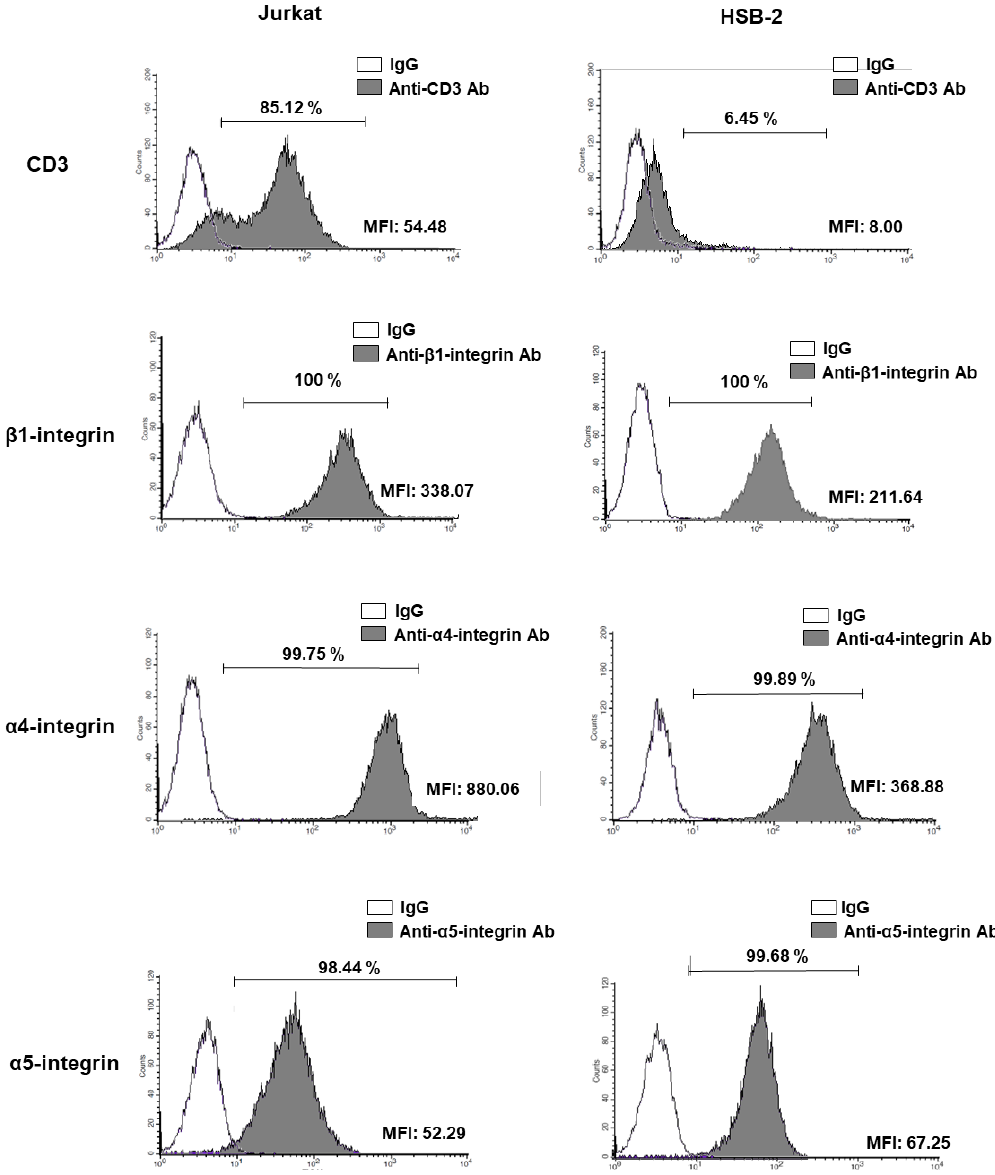
Figure 1. α4, α5 and β1 integrin chain expression in human T -ALL cell lines. Figure 1. α 4, α 5 and β 1 integrin chain expression in human T-ALL cell